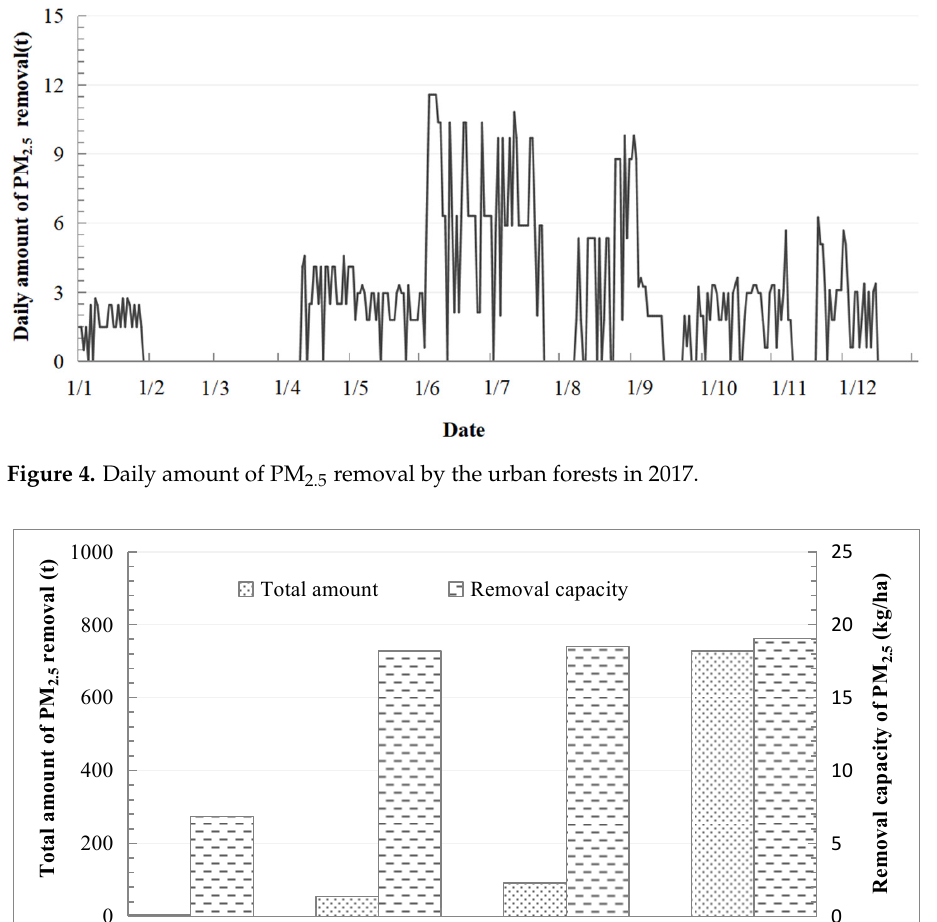
Figure 4. Daily amount of PM 2.5 removal by the urban forests in 2017.